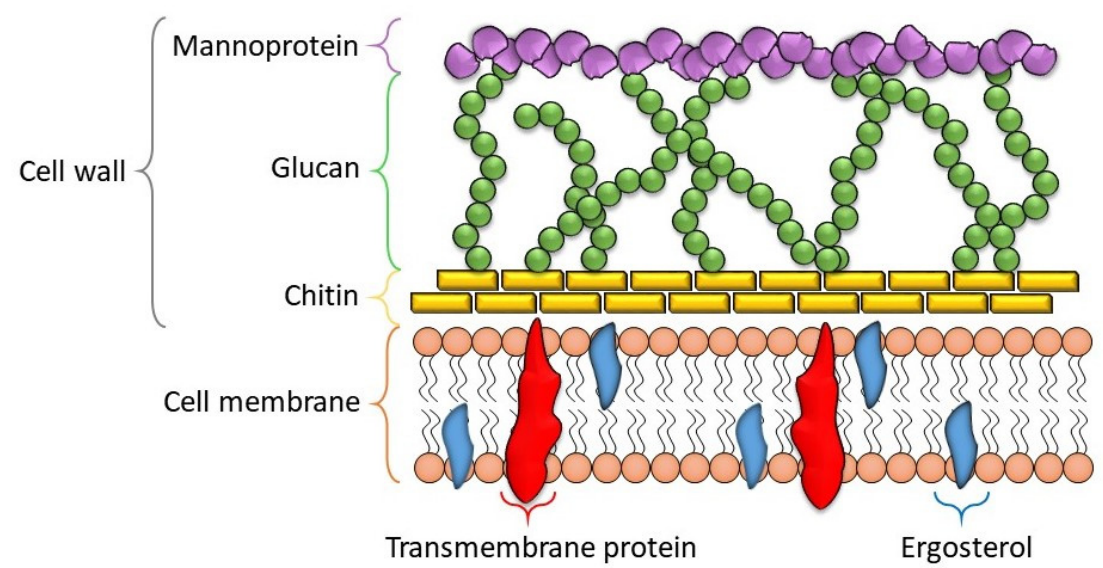
Figure 1. Fungal cell wall organization and membrane.